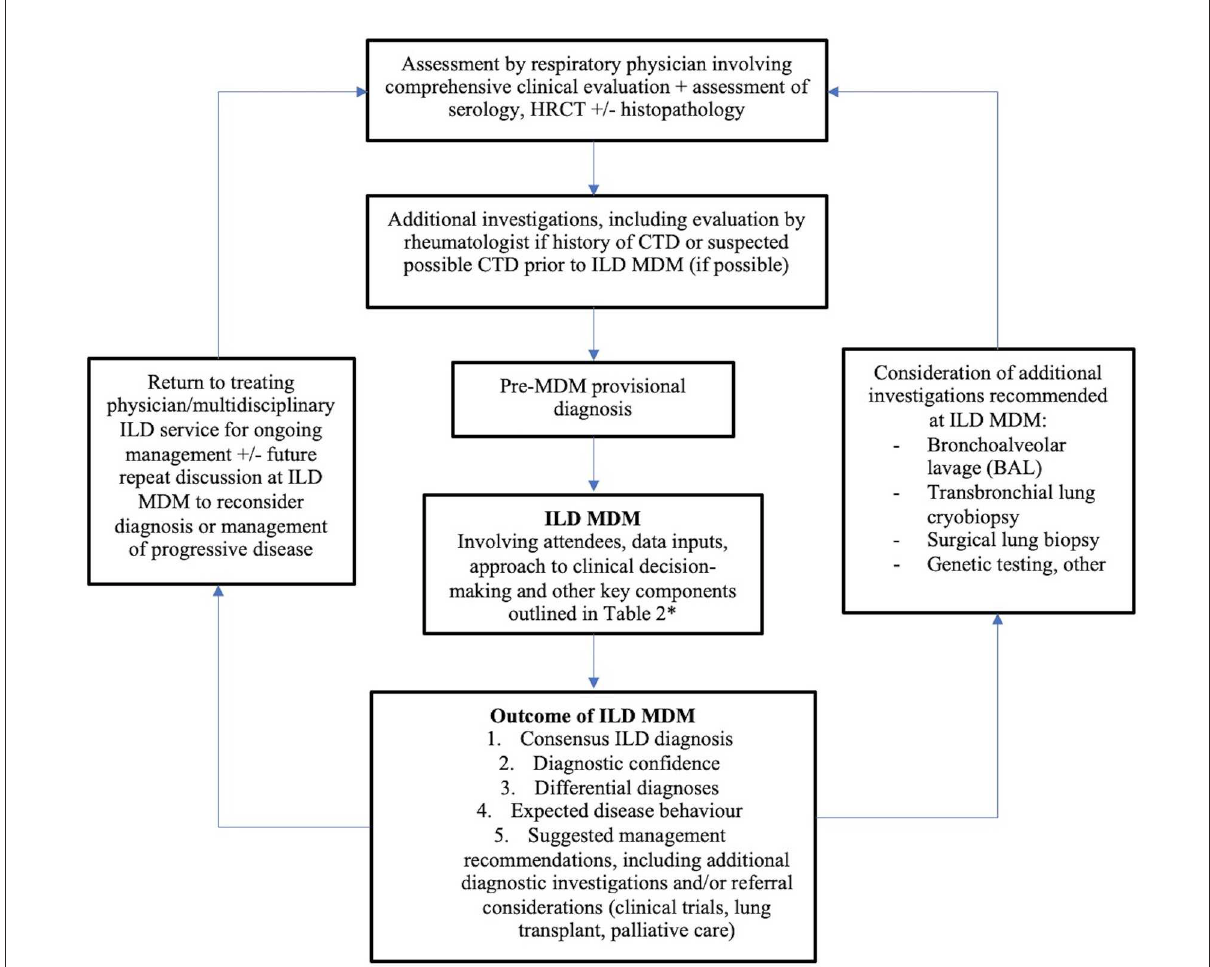
FIGURE1 The role of the ILD MDM in diagnosis and ongoing clinical care a . a Adapted from Prasad et al. (5). *Plus attendance by rheumatologist and/or immunologist where